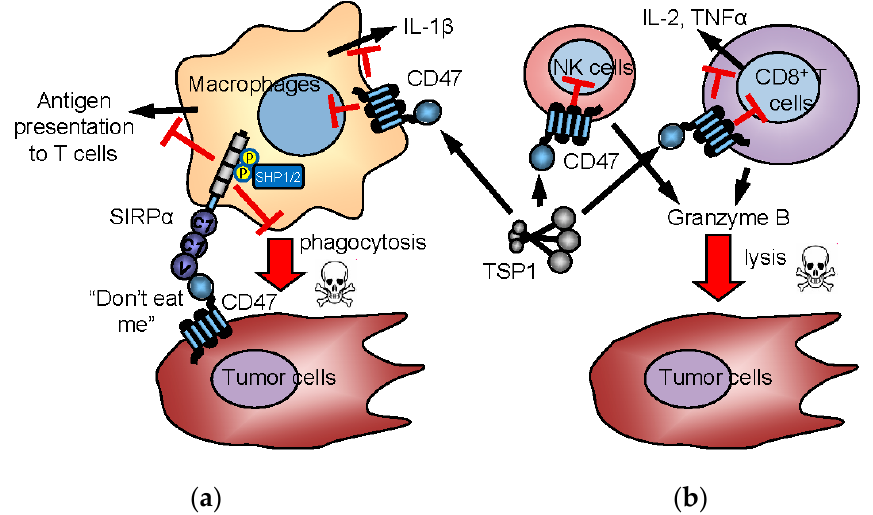
Figure 3. Innate and adaptive immune checkpoint functions of CD47 and TSP1. In the “don’t eat me” model ( a ), CD47 on tumor cells interacts with SIRP α on macrophages to induce inhibitory signaling, preventing the phagocytic killing of tu- mor cells. CD47 is also expressed by immune cells and mediates TSP1 signaling in immune cells. TSP1 interaction with CD47 on NK cells and cytotoxic T cells inhibits their activation and limits granzyme B production that mediates antigen- dependent lysis of tumor cells ( b ). Inhibitory TSP1 signaling mediated by CD47 on macrophages and dendritic cells limits their presentation of antigens to T cells and limits macrophage production of IL-1 β